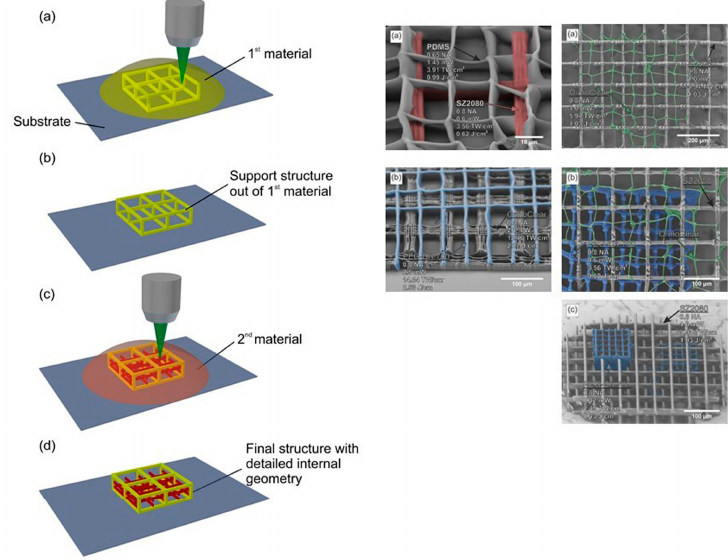
di ff erent polymeric materials ( right ) Figure 11. Direct writing laser procedure (left). Final structures of fabricated scaffolds consist of two different polymeric materials (right) [121].